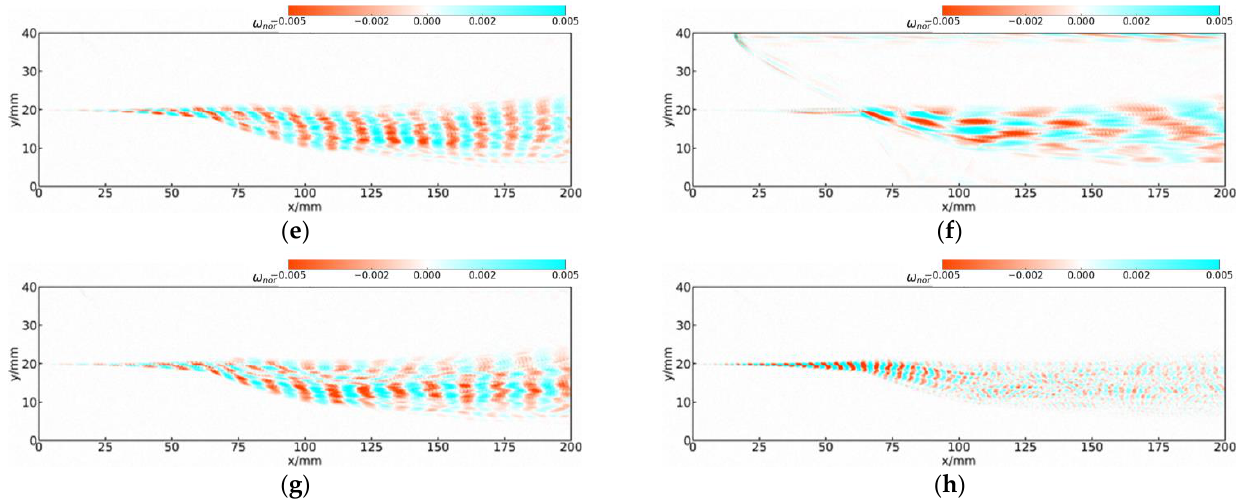
Figure 17. Dimensionless vorticity contour of the first eight modes in Case 3: ( a ) the 1st mode; ( b ) the 2nd mode; ( c ) the 3rd mode; ( d ) the 4th mode; ( e ) the 5th mode; ( f ) the 6th mode; ( g ) the 7th mode; ( h ) the 8th mode.